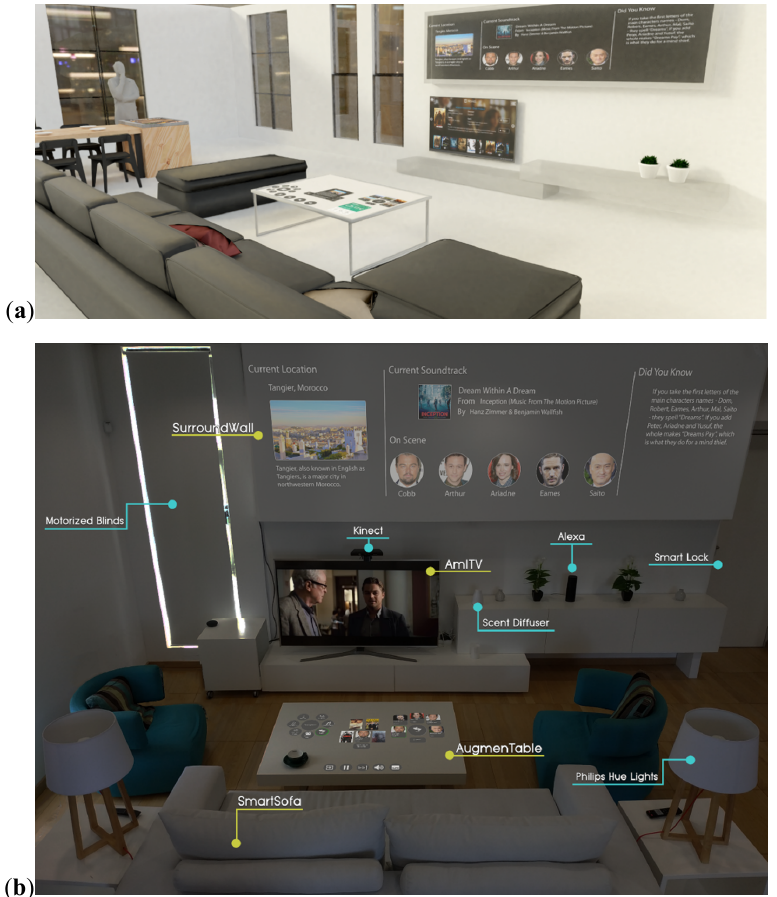
Figure 1. ( a ) The 3D representation of the living room as it resulted from the prototyping phase; ( b ) The current “Intelligent Living Room” setup.